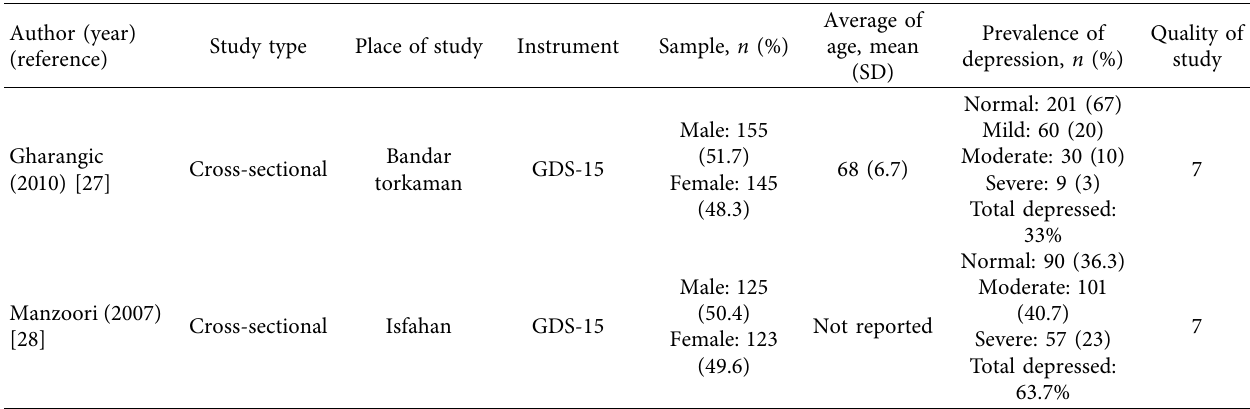
Figure 1: Process of study selection (PRISMA). Table 1: Characteristics of the included studies ( N �